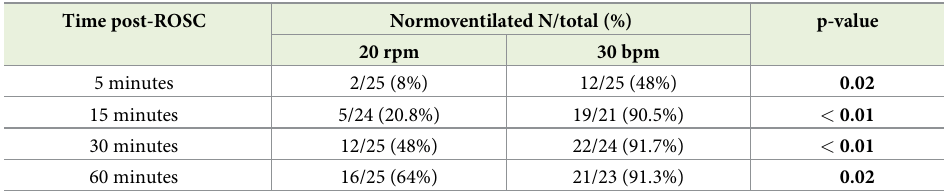
Table 4. Normoventilated piglets (PaCO2 30–50 mmHg) after ROSC. Time post-ROSC Normoventilated N/total (%) p-value 20 rpm 30 bpm 5 minutes 2/25 (8%) 12/25 (48%) 0.02 15 minutes 5/24 (20.8%) 19/21 (90.5%) < 0.01 30 minutes 12/25 (48%) 22/24 (91.7%) < 0.01 60 minutes 16/25 (64%) 21/23 (91.3%) 0.02 Data are expressed as medians (IQR). Statistically significant values (p < 0.05) appear in bold type. ROSC: return of spontaneous